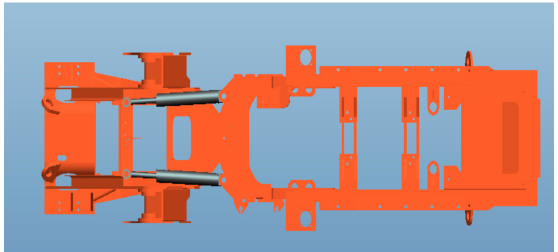
Figure 1. The straight form of steering mechanism for an articulated off-road vehicle (AORV).